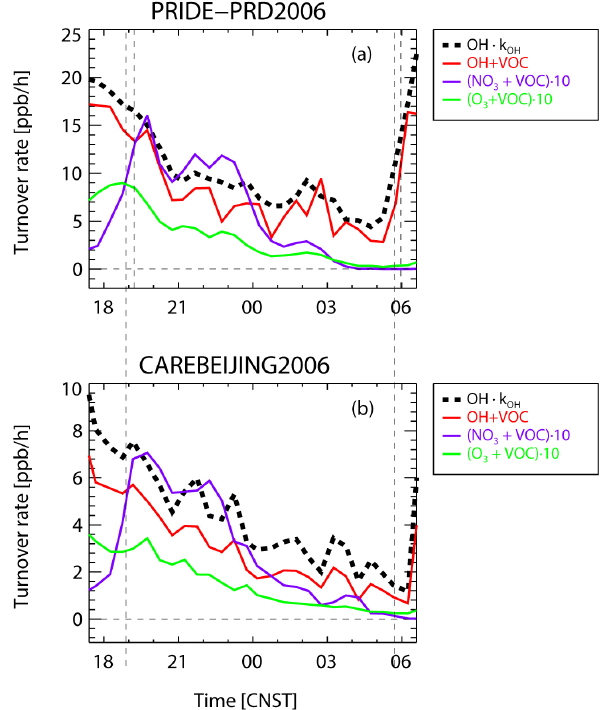
Figure 5. Nighttime oxidation rates of VOCs (i.e., observed HCs + modeled OVOCs) for their reaction with OH, NO 3 , and O 3 during PRIDE-PRD2006 and CAREBEIJING. The VOC oxidation rate for OH was estimated as the difference of the measured total OH reac- tion rate (k OH × [OH], black dashed line) and the calculated reaction rates of OH with CO and NO x . The reaction rates of NO 3 and O 3 are taken from the base model and use modeled NO 3 and measured O 3 concentrations, respectively. The vertical dashed lines denote the sunset and